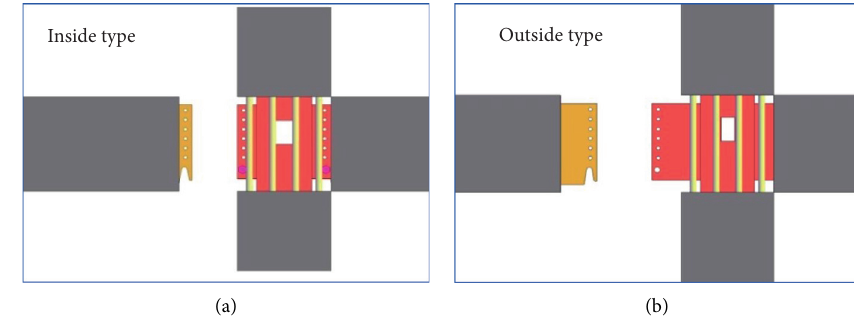
Figure 2: Proposed connection type. (a) Inside connection. (b) Outside